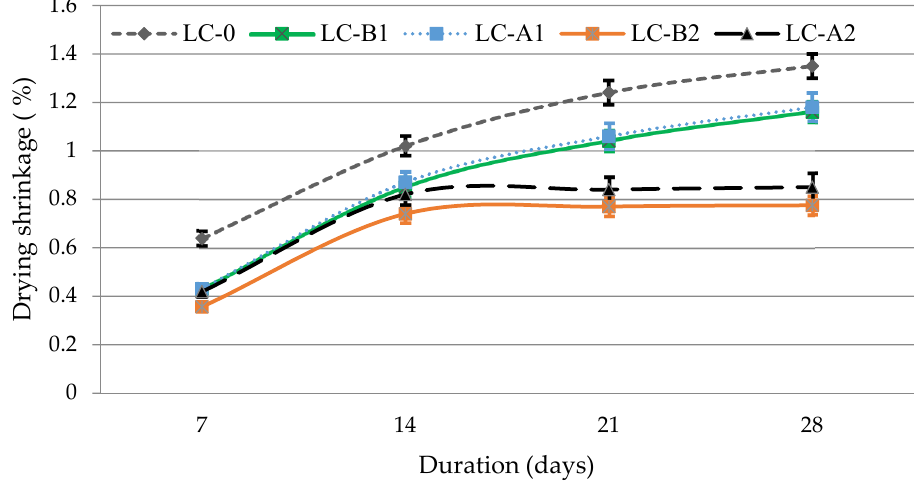
Figure 5. Drying shrinkage of lightweight composite while curing .